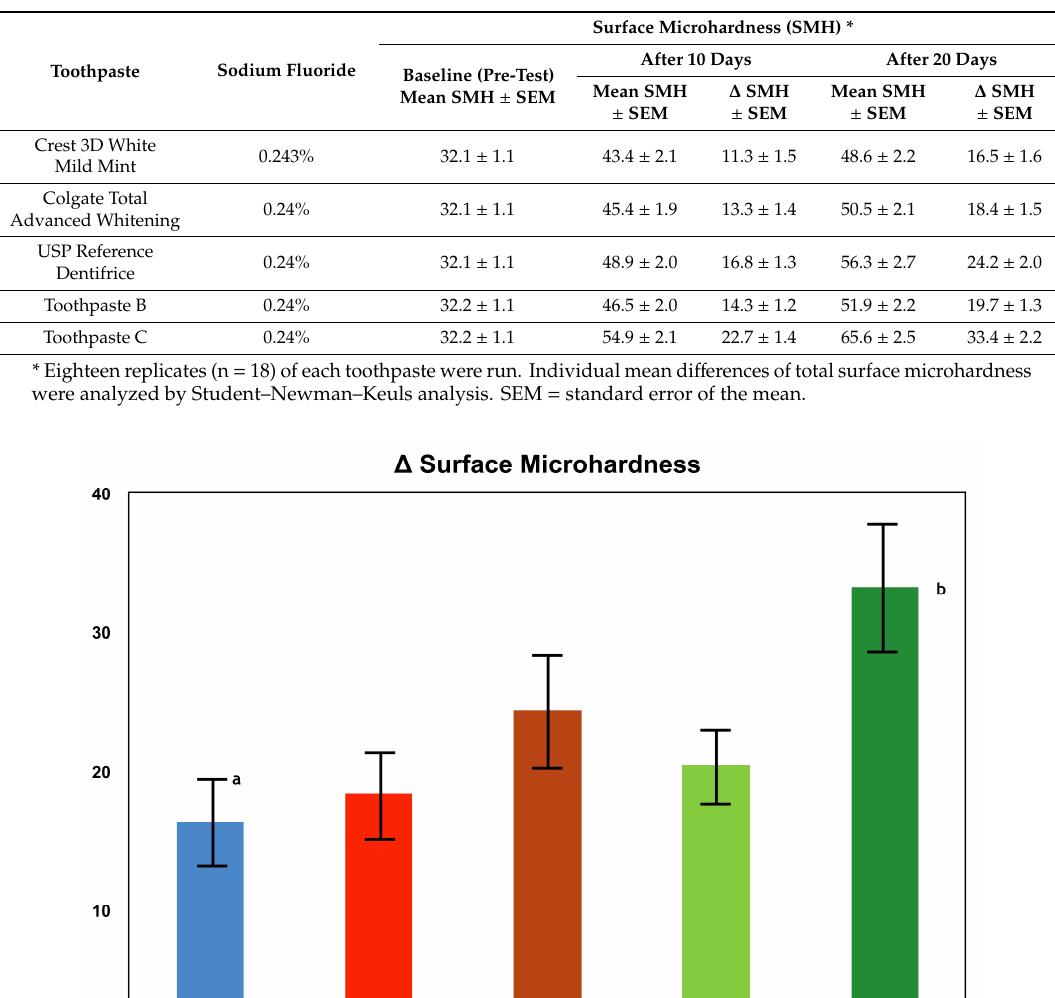
Table 1. Surface microhardness after 10 and 20 days of remineralization treatment.